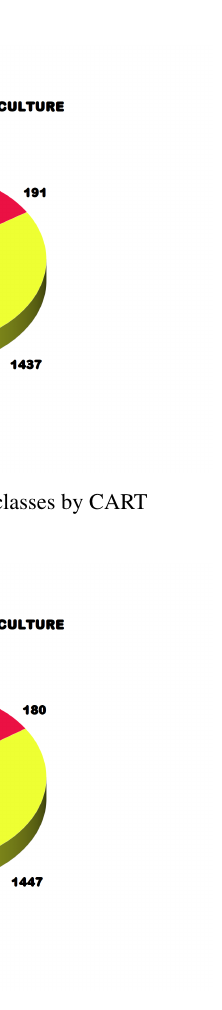
Figure 6: Area of each landcover classes by RF